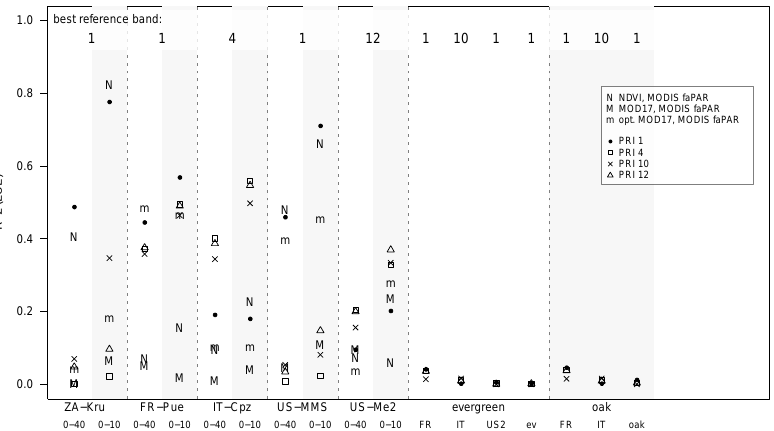
Fig. 3. R 2 of modelled LUE vs. LUE MODIS for two ranges of sensor viewing zenith angle: 0–40 ◦ and 0–10 ◦ . The most suitable reference band for each site is displayed at the top. The same pattern appears when using the root mean square error (not